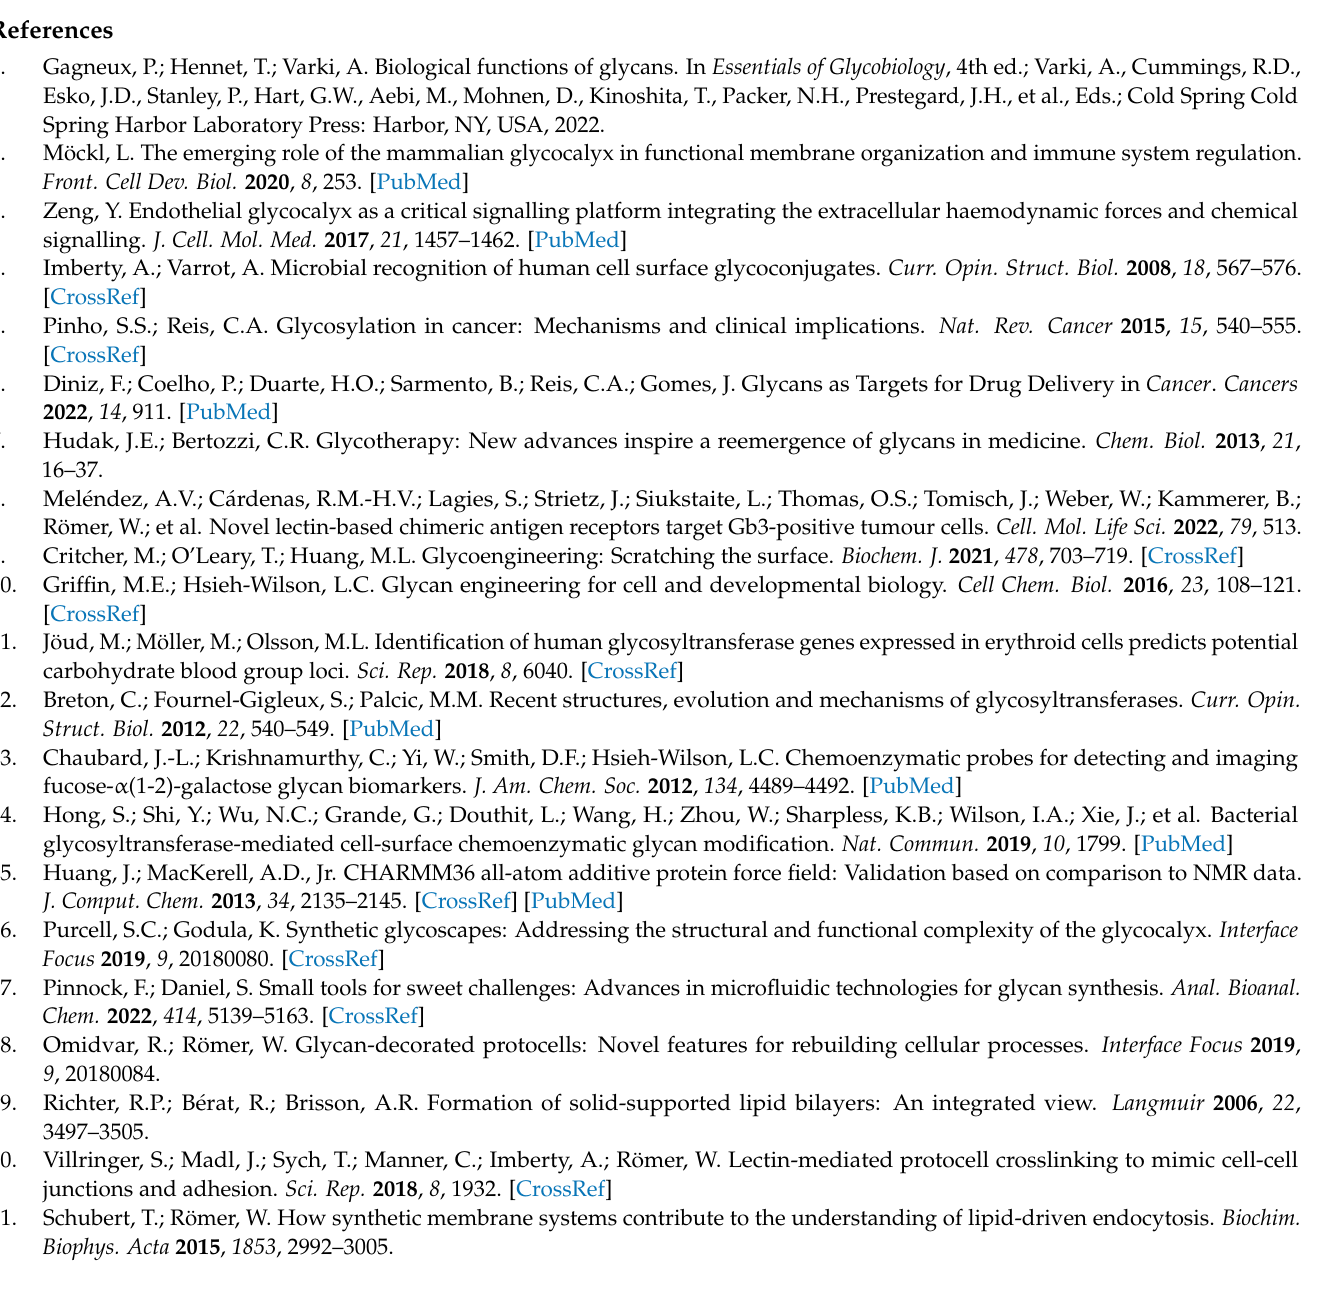
(a) The whole membrane with LacCer bound to LgtC was considered as a ligand to estimate the binding energy. The SD value largely prevailing over the mean value of ∆ H total is due to large mean values annihilating upon summing ∆ H gas and ∆ H desolv . (b) The related ITC data calculated for α 3GT for the binding of lactose in the presence of UDP were